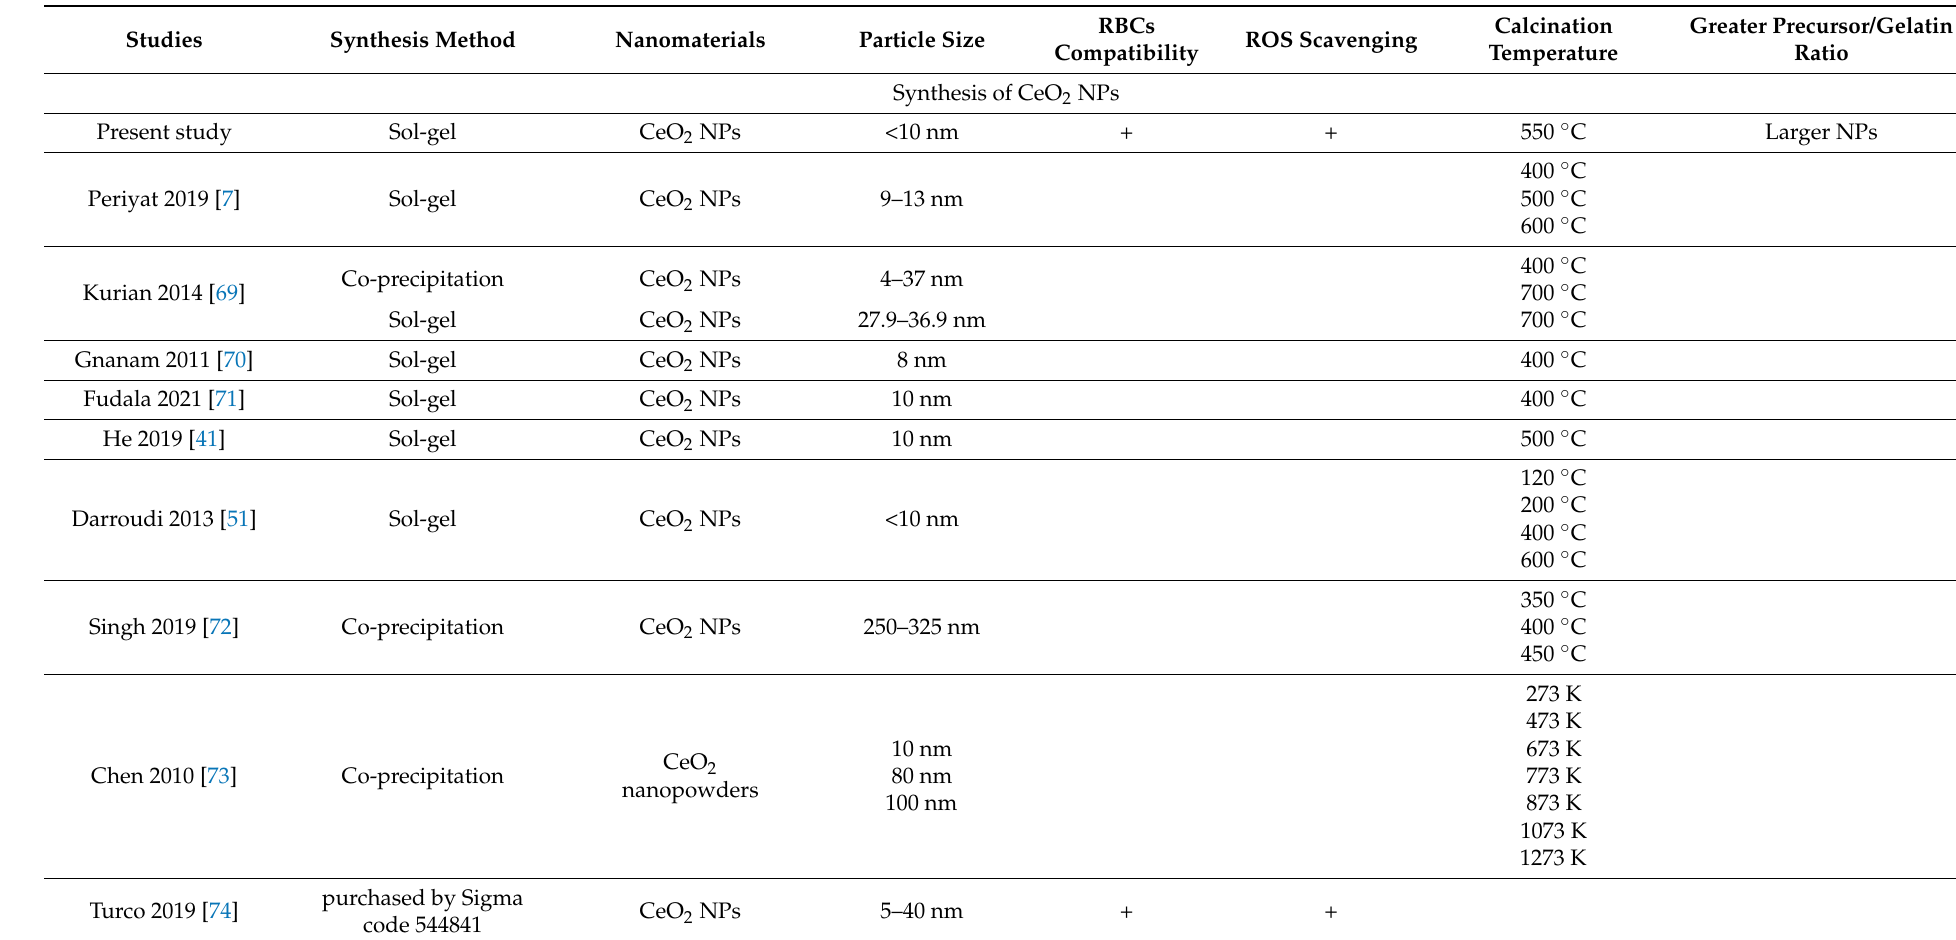
Table 2. Studies investigating the synthesis of CeO 2 NPs and NPs using